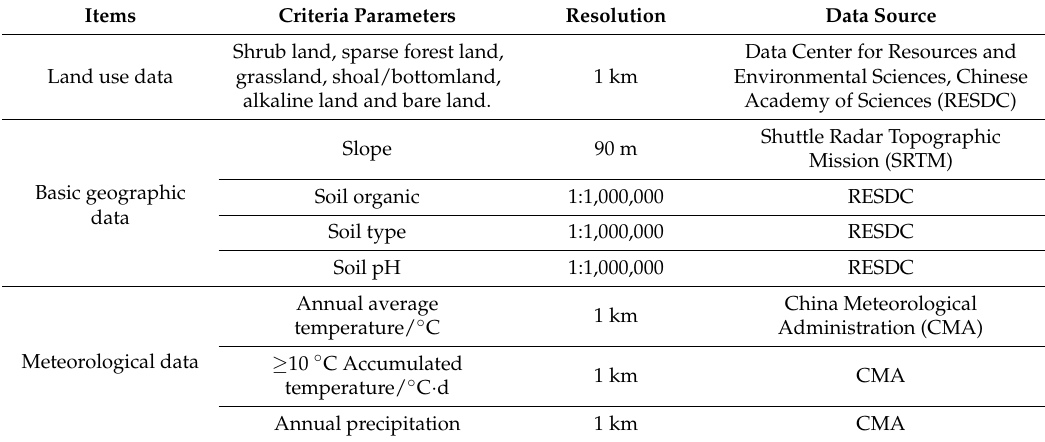
Table 1. Basic data for marginal land